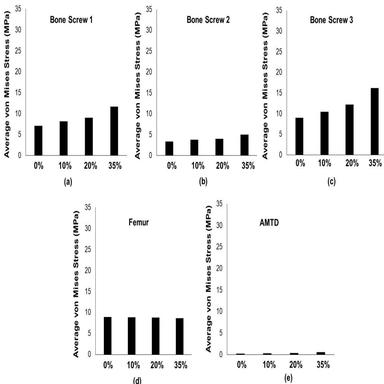
The average von Mises stress distribution in the (a) bone screw 1, (b) bone screw 2, (c) bone screw 3, (d) femur, and (e) AMTD due to the material reduction at the femur bone in case of the non-bonded condition.